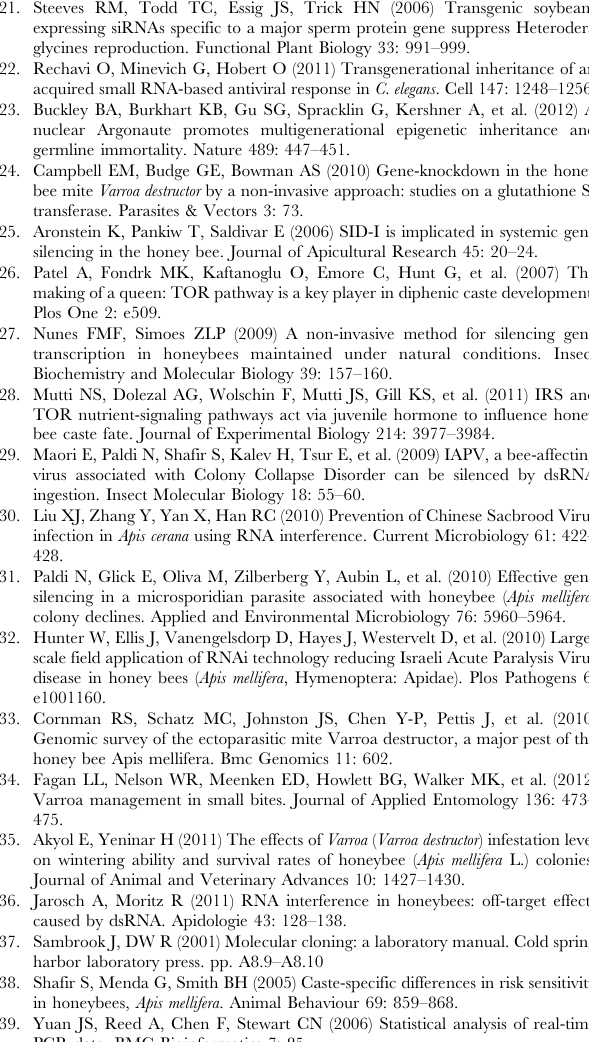
Table S4 List of primers and probes used for real-time, semi-quantitative RT-PCR assays and Northern blot assay. * Designation of Varroa sequences as per Table